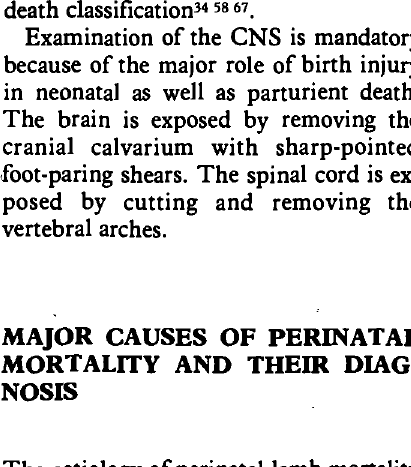
Table 1: Perinatal lamb mortality reiative to the reproductive performance of selected, mixed-age, spring-lambing Merino flocks with lamb marking percentages above the Australian average (70%) [Haughey, unpublished